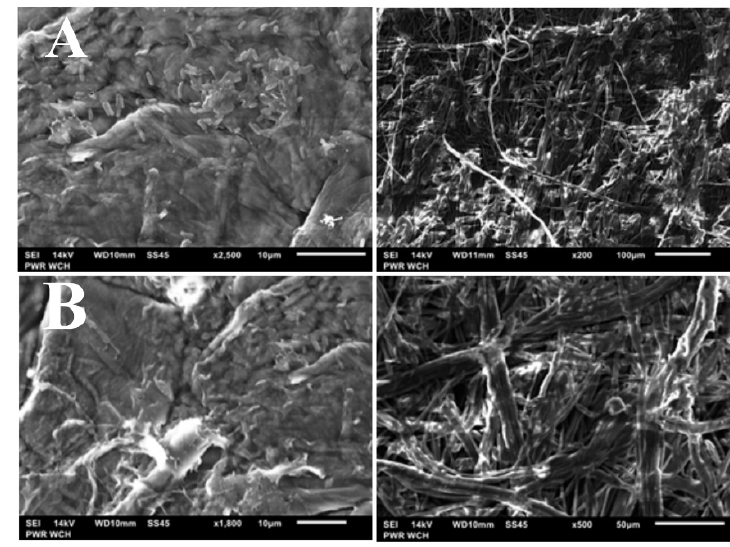
Figure 6. SEM images of cellulose acetate ( A ) and polyamide ( B ) membranes: after 24 h contact with the activated sludge (left) and after 10 min of the non-thermal plasma treatment (right).